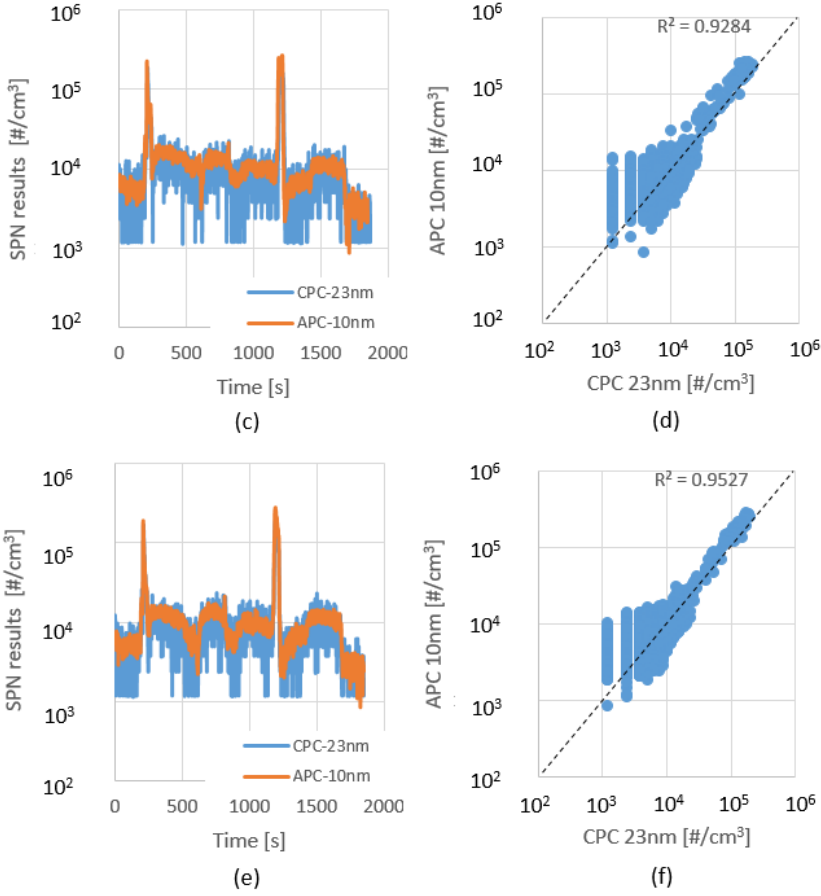
Figure 9. Transient particle concentration over 1st ( a ); 2nd ( c ); 3rd ( e ) WHSC cycle; Proportion of variance between <10 nm and <23 nm results over 1st ( b ); 2nd ( d ); 3rd ( f ) WHSC cycle. APC = AVL Particle Counter; CPC = Condensation Particle Counter; SPN = Solid Particle Number.